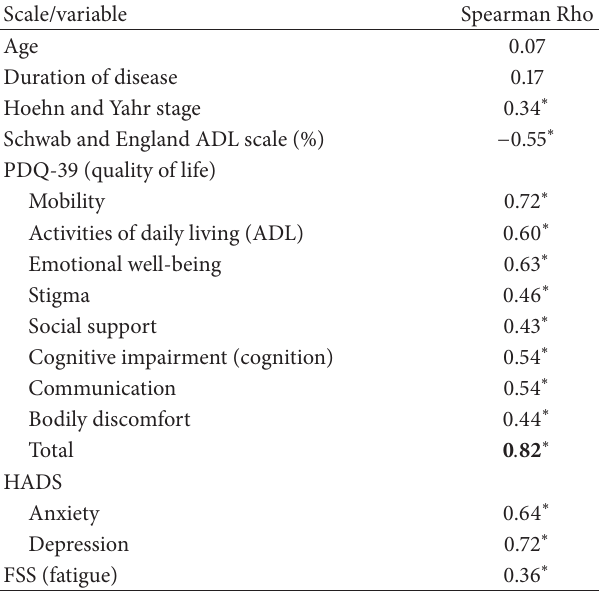
Table 4: Spearman correlation for convergent validity of the SCOPA-PS questionnaire regarding other measured scales and variables in Iranian Parkinson’s disease patients (𝑛 = 110)